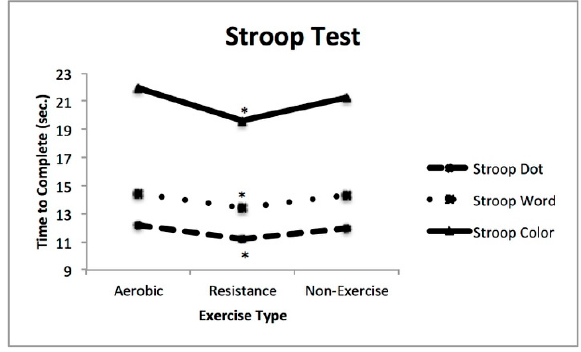
Figure 2. Time to complete Stroop Dot, Word, and Color tests following various exercise types. * Denotes statistical significance ( p < 0.05).